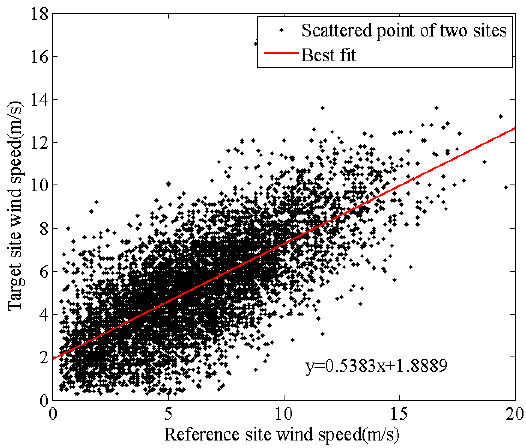
Figure 13. Scattered plot of wind speed of target site versus reference site with best fit line from 1 January 2012 to 31 December 2012.